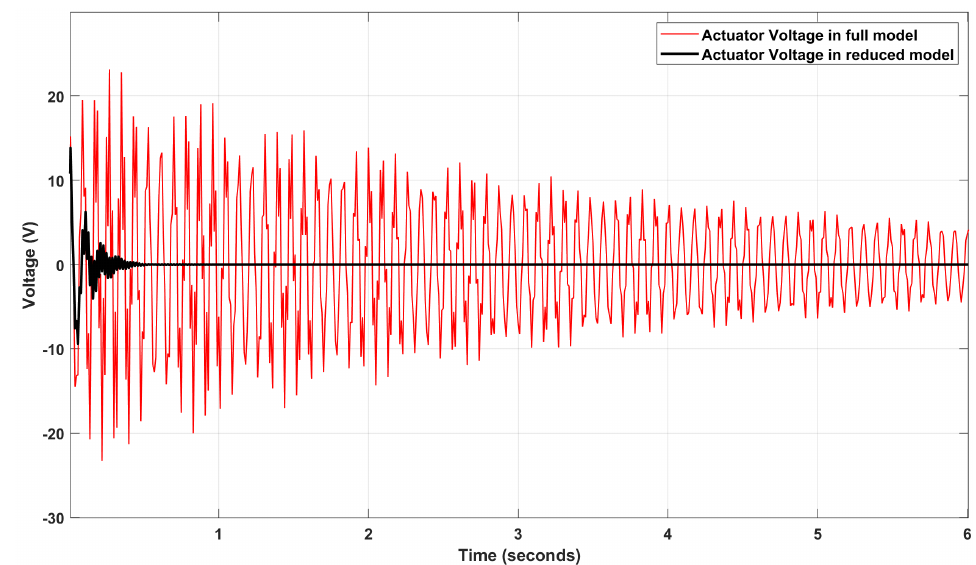
Figure 9. Actuator input Voltage using full and reduced LQG-Kalman models for T = 25 ◦ C with 8 distributed pairs of sensor/actuator and 20 selected sensors nodes.